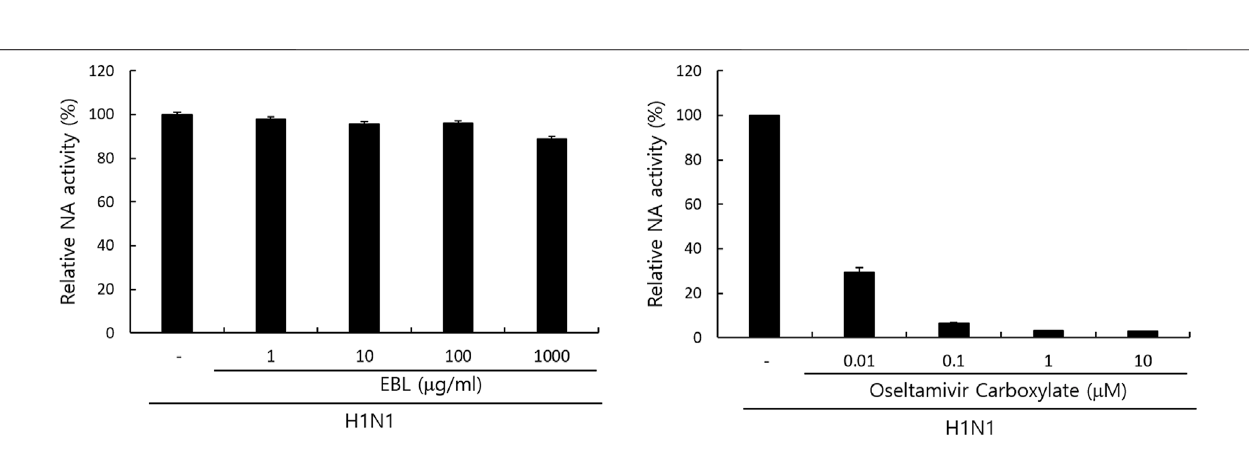
Frontiers in Pharmacology |